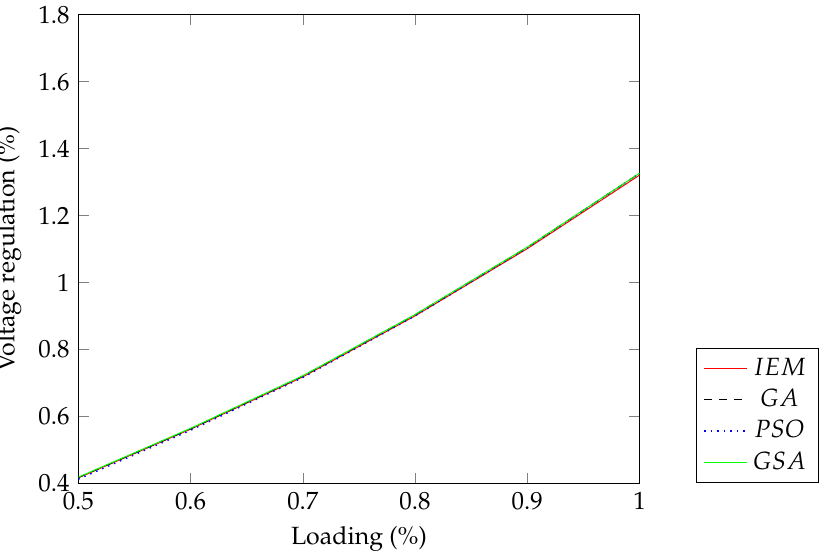
Figure 8. Voltage regulation by varying the load on the 33 MVA single-phase